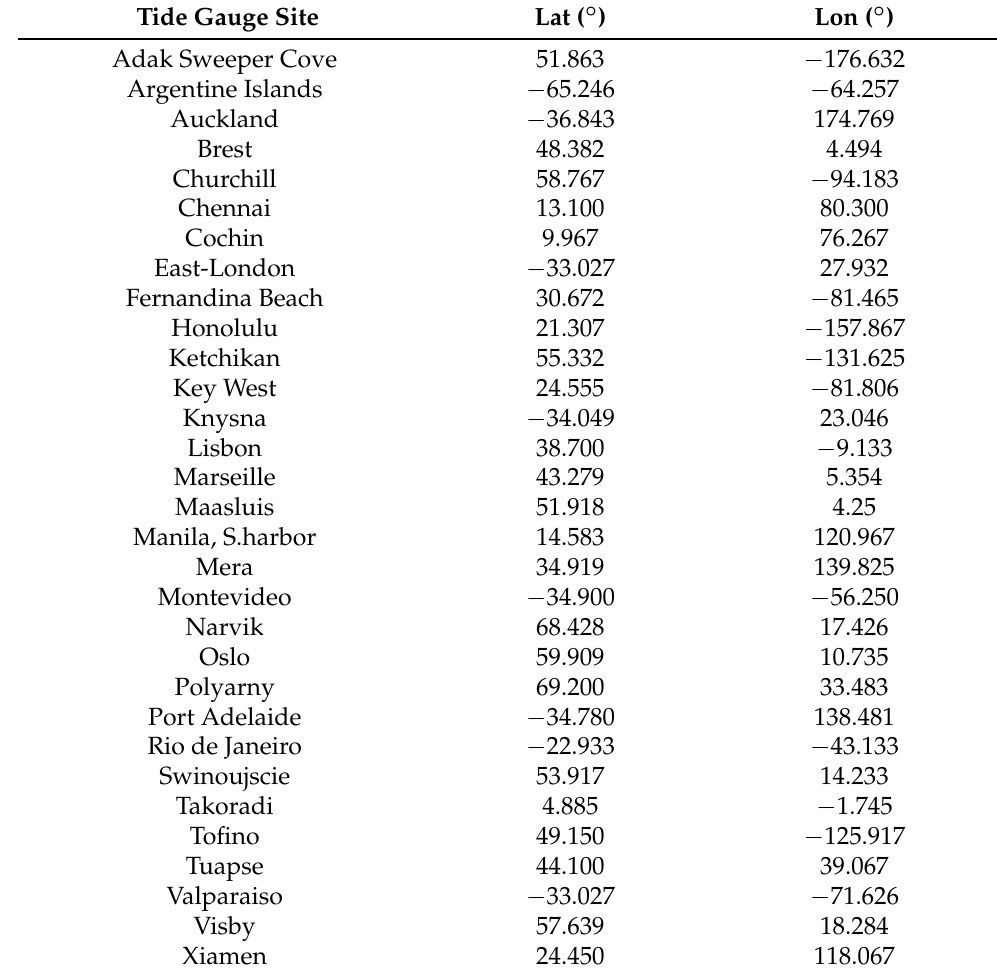
Table 1. List of tide gauges selected in this study to build the GSLTG